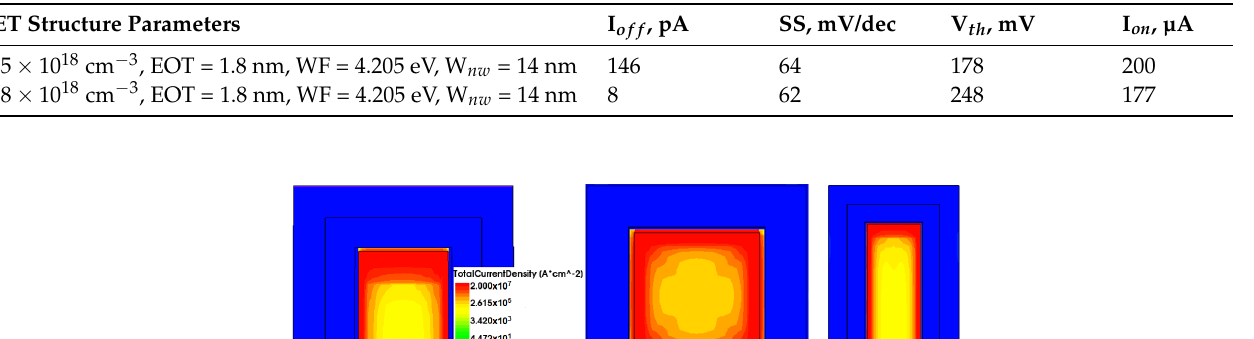
Table 2. Comparison of options to reduce the leakage current by changing various parameters of the